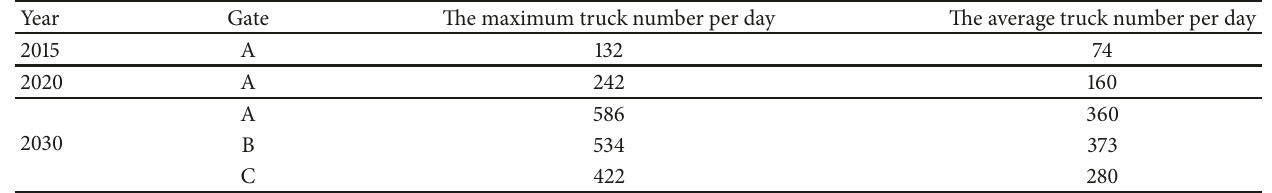
Table 4: The traffic volume at port gate in three representative years.